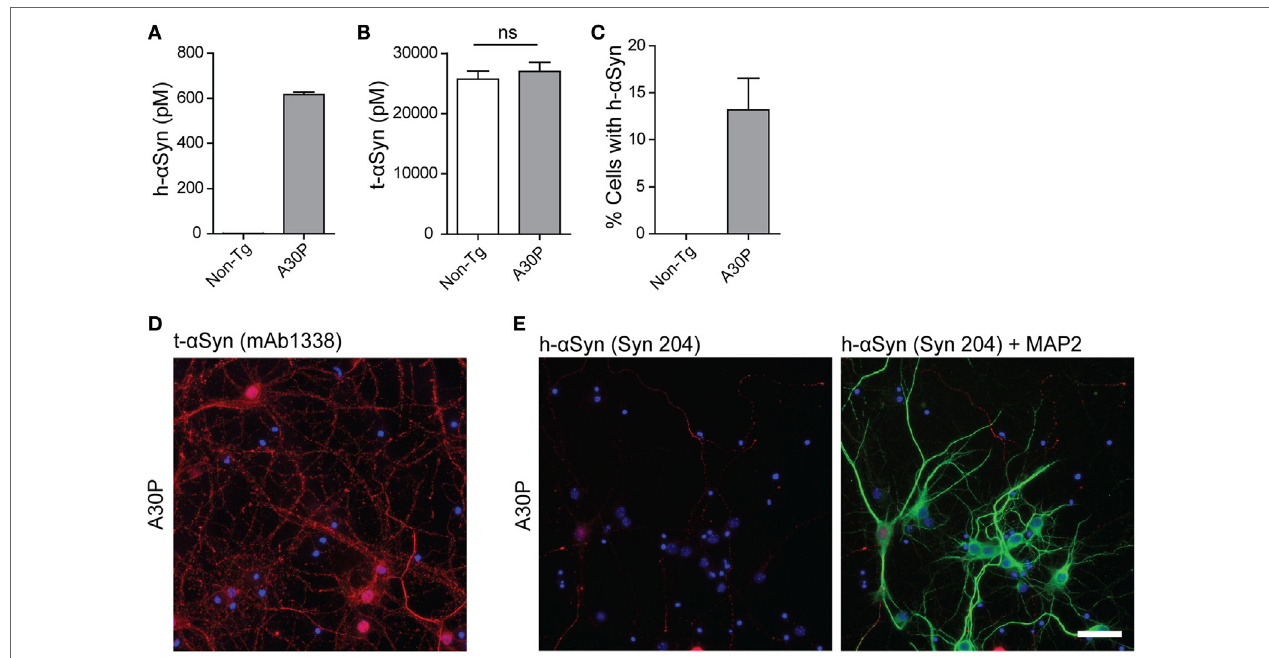
FigUre 2 | Characterization of primary neurons from tg A30P mice. Levels of h-alpha-synuclein ( α Syn) in lysates of non-tg and A30P neuronal cultures were measured by ELISA, using the h- α Syn specific antibody 4B12 as a capture antibody (a) . Levels of total (t)- α Syn (m- α Syn + h- α Syn) in lysates of non-tg and A30P neuronal cultures were measured by ELISA, using clone 42 as a capture antibody. Two-tailed Student’s t -test, non-significant (ns), error bars represent the SEM (B) . Quantification of h- α Syn positive non-tg and A30P neurons, observed by immunofluorescence with h- α Syn specific antibody Syn 204 (c) . Representative images of immunofluorescence of tg A30P neurons with t- α Syn mAb1338 (D) . Representative images of immunofluorescence with h- α Syn specific antibody Syn 204 of A30P cortical neurons (red). MAP2 neuronal marker (green) and DAPI (blue) (e) . Scale bar 50